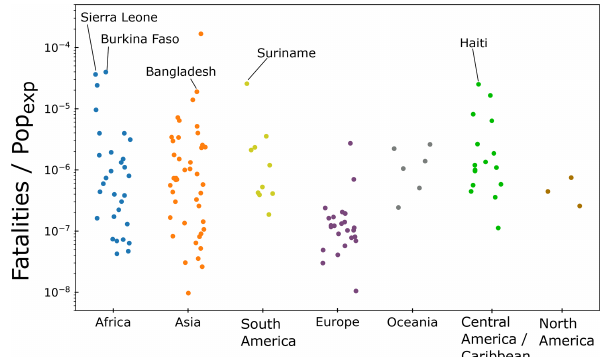
Figure 7. Number of fatalities divided by Pop exp , for each conti- nent. The wide spread of values in Africa and Asia is likely a re- flection of the diversity of nation-to-nation landslide vulnerability. Offsets on the x axis are for visual distinction between points to avoid